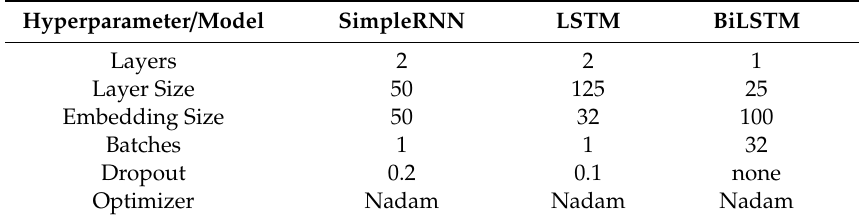
Table 6. Best Models’ Hyperparameters.